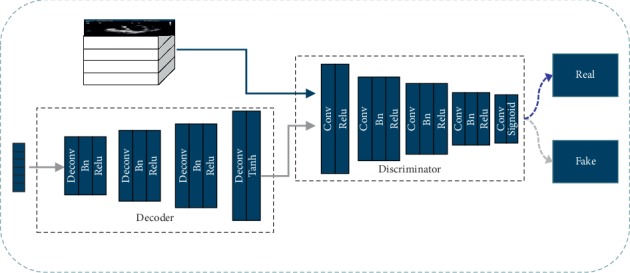
S2U Parent Network.